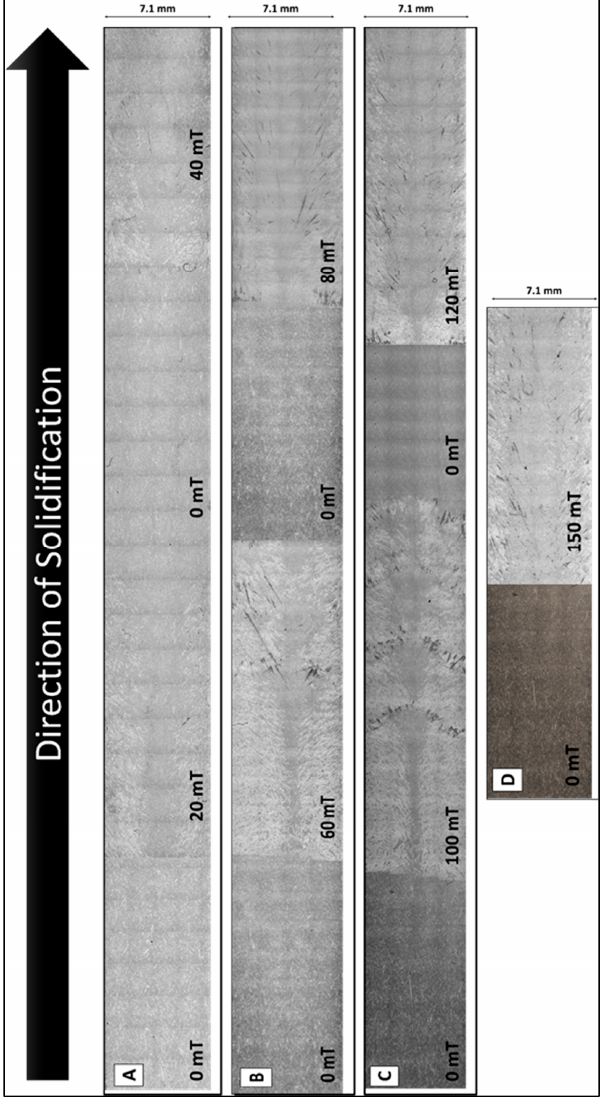
Figure 3. The solidified macro-structure for the samples in four steps (M = 50 × ). ( A ) Sample A; ( B ) Sample B; ( C ) Sample C; ( D ) Sample